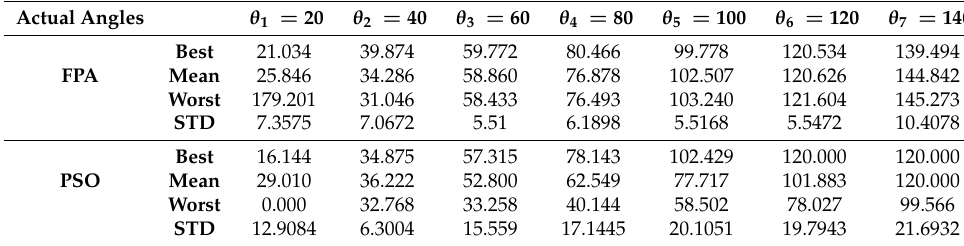
Table 3. Estimation accuracy and STD for seven targets at SNR = − 10